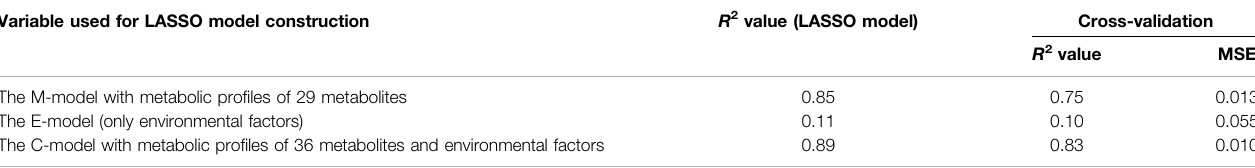
TABLE 1 | The prediction accuracies of the three models in